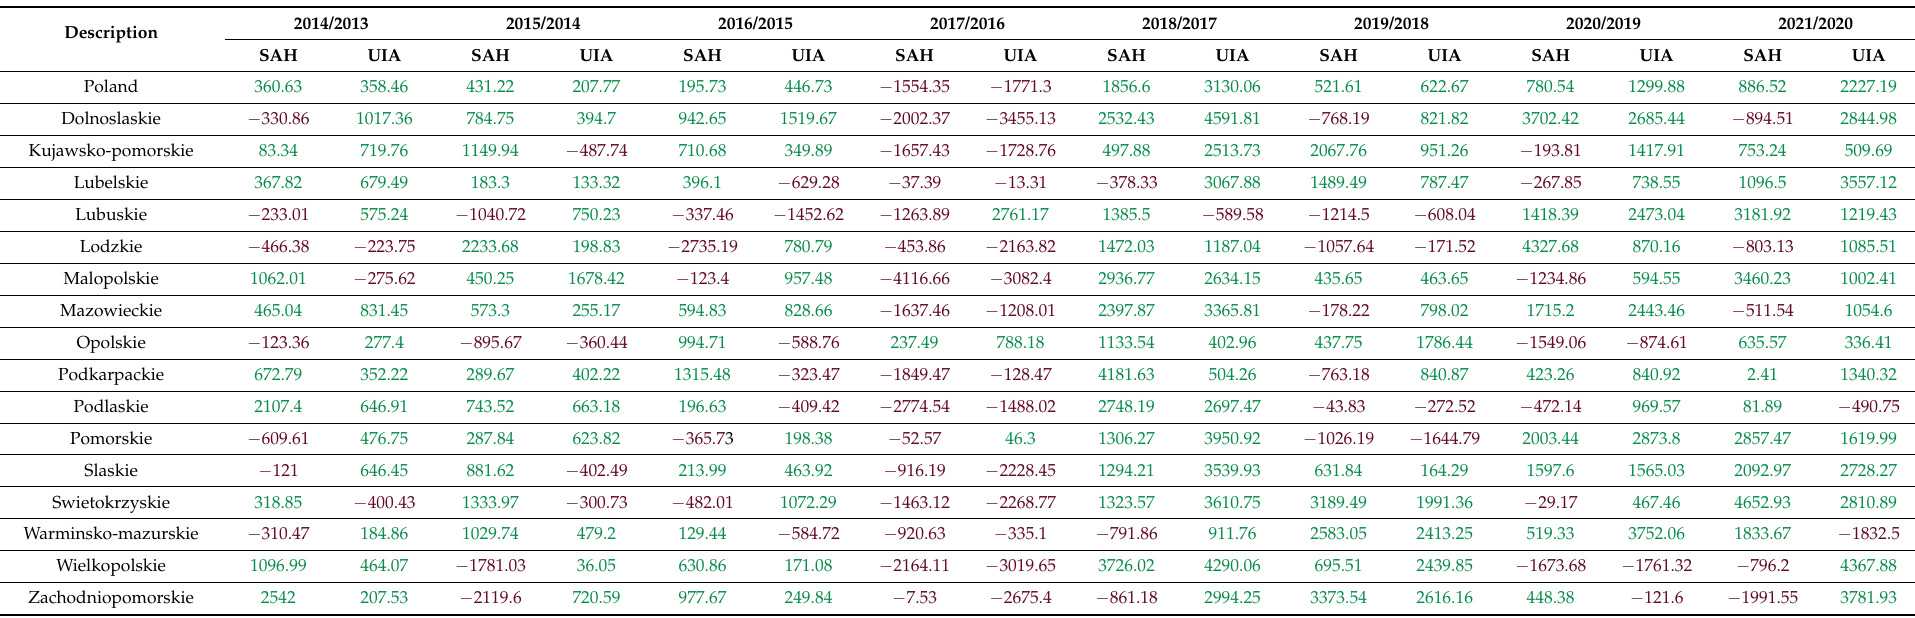
Table A2. Changes in the levels of reported services per patient by value in PLN (PLN) for provinces in the years 2013–2021 in total and for SAH and UIA